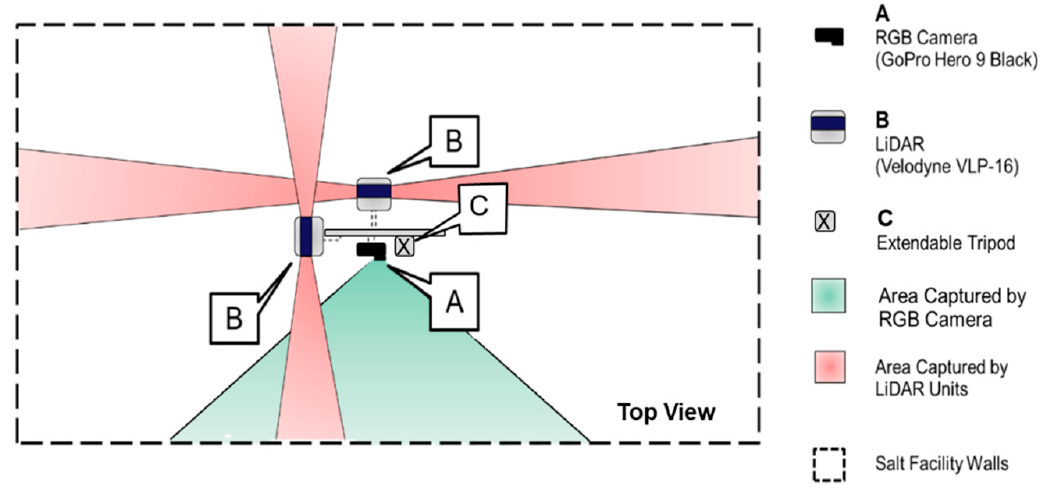
Figure 2. Horizontal coverage of the LiDAR units and RGB camera on the SMART system. RGB camera: The SMART system uses a GoPro Hero 9 camera, which weighs 158 g. The camera has a 5184 × 3888 CMOS array with a 1.4 μm pixel size and a lens with a nominal focal length of 3 mm. Horizontal FOV of 118° and 69° vertical FOV enable the camera to cover roughly 460 square meters with a 10 m range. A schematic diagram of the camera